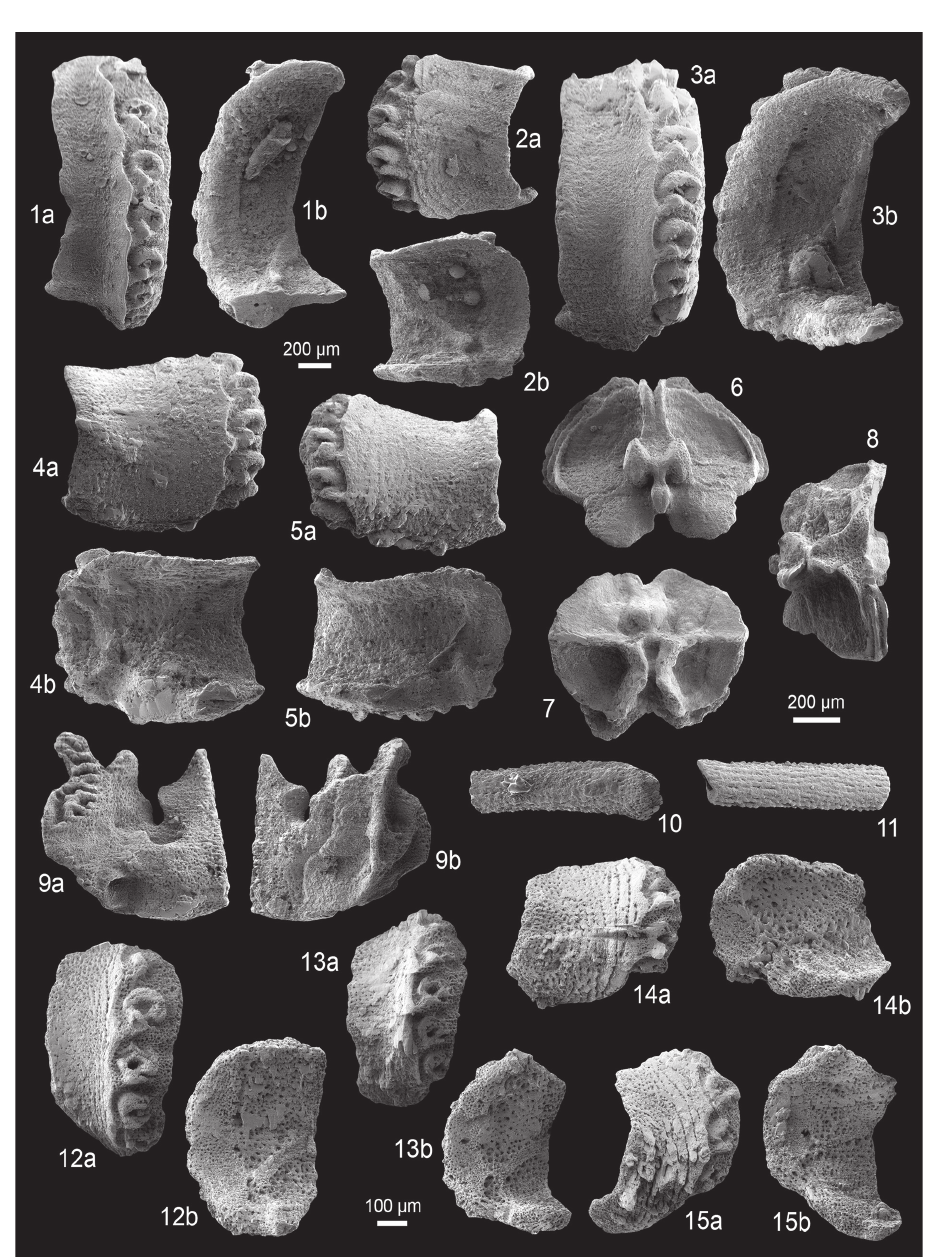
Fig. 17. Fossil skeletal plates of ophiacanthid brittle stars; lateral arm plates (LAPs) in external (a) and internal (b) views. 1-2. Ophiotreta striata (Kutscher & Jagt, 2000) comb. nov. from the early Maastrichtian of Rügen, Germany. 1. GZG.INV.78588, proximal LAP. 2. GZG.INV.78589, distal LAP. 3-11. Ophiotreta dendrophyllicola sp. nov. from the middle Danian (Paleocene) of Fakse, Denmark. 3. MGUH 30236 (holotype), proximal LAP. 4. NHMM 2012 050 (paratype), median LAP. 5. NHMM 2012 051 (paratype), distal LAP. 6. NHMM 2012 052 (paratype), vertebra in distal view. 7. NHMM 2012 053 (paratype), vertebra in proximal view. 8. NHMM 2012 054 (paratype), vertebra in dorsal view. 9. NHMM 2012 055 (paratype), oral plate in adradial (a) and abradial (b) view. 10. NHMM 2012 056 (paratype), arm spine fragment. 11. NHMM 2012 057 (paratype), arm spine fragment. 12-15. Ophiotreta hedone sp. nov. from the middle Lutetian (Eocene) of Grignon, France. 12. GZG.INV.78590 (holotype), proximal LAP. 13. GZG.INV.78591 (paratype), median LAP. 14. GZG.INV.78592 (paratype), distal LAP. 15. GZG.INV.78593 (paratype), median LAP. One common scale bar per